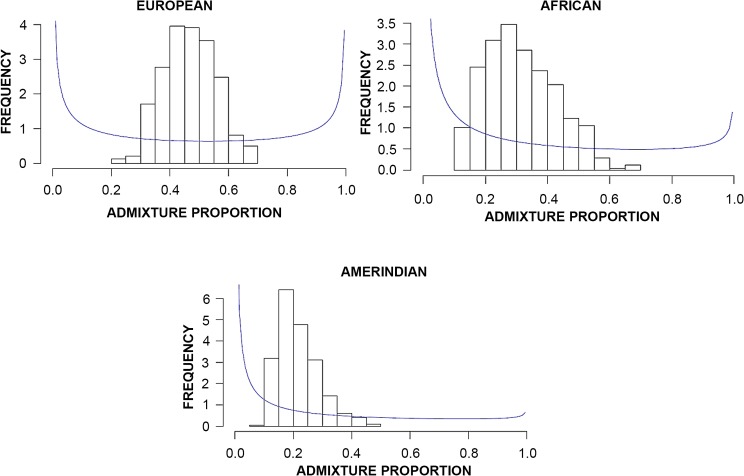
Dirichlet distributions of the ancestral components of the study population.The European component had a normal distribution and consisted of 40–60% of the study population. The African component had a non-normal distribution and consisted of less than 30% of the study population. The Native American (Amerindian) component had a non-normal distribution and consisted of 20% of the study population.